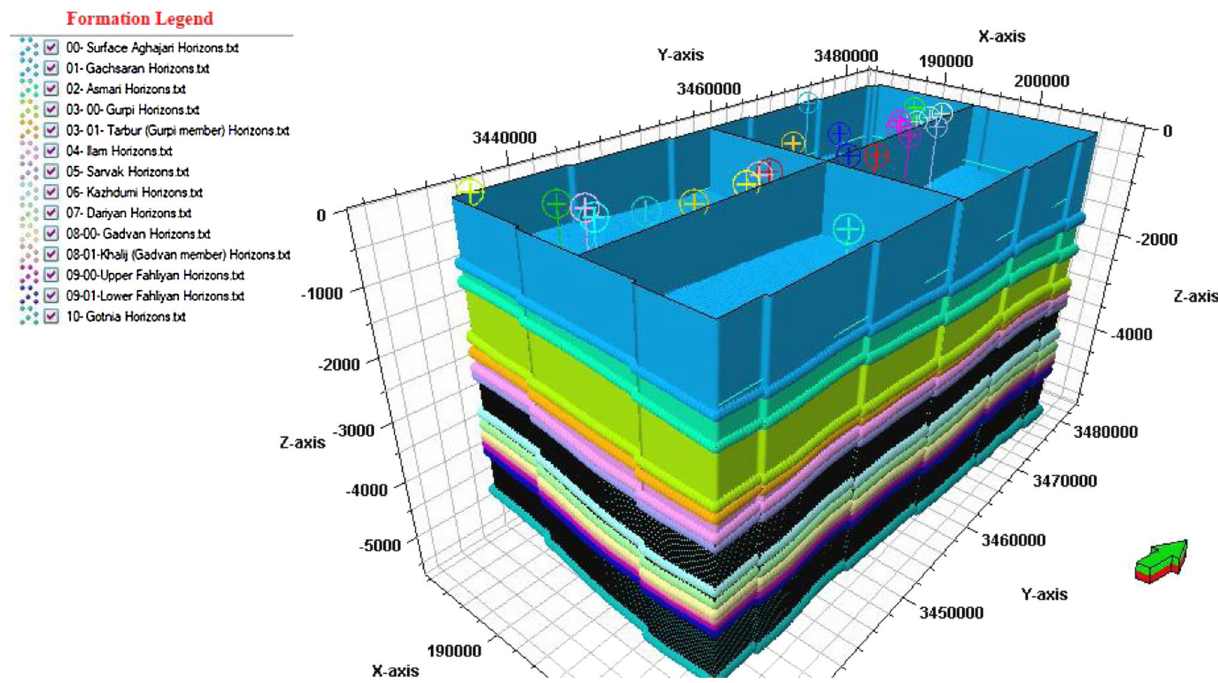
Fig. 19 Three-dimensional geological model of South Azadegan Field using seismic sections and drilling data along with the location of used The initial cube of the minimum and maximum mud weight See Fig. 20